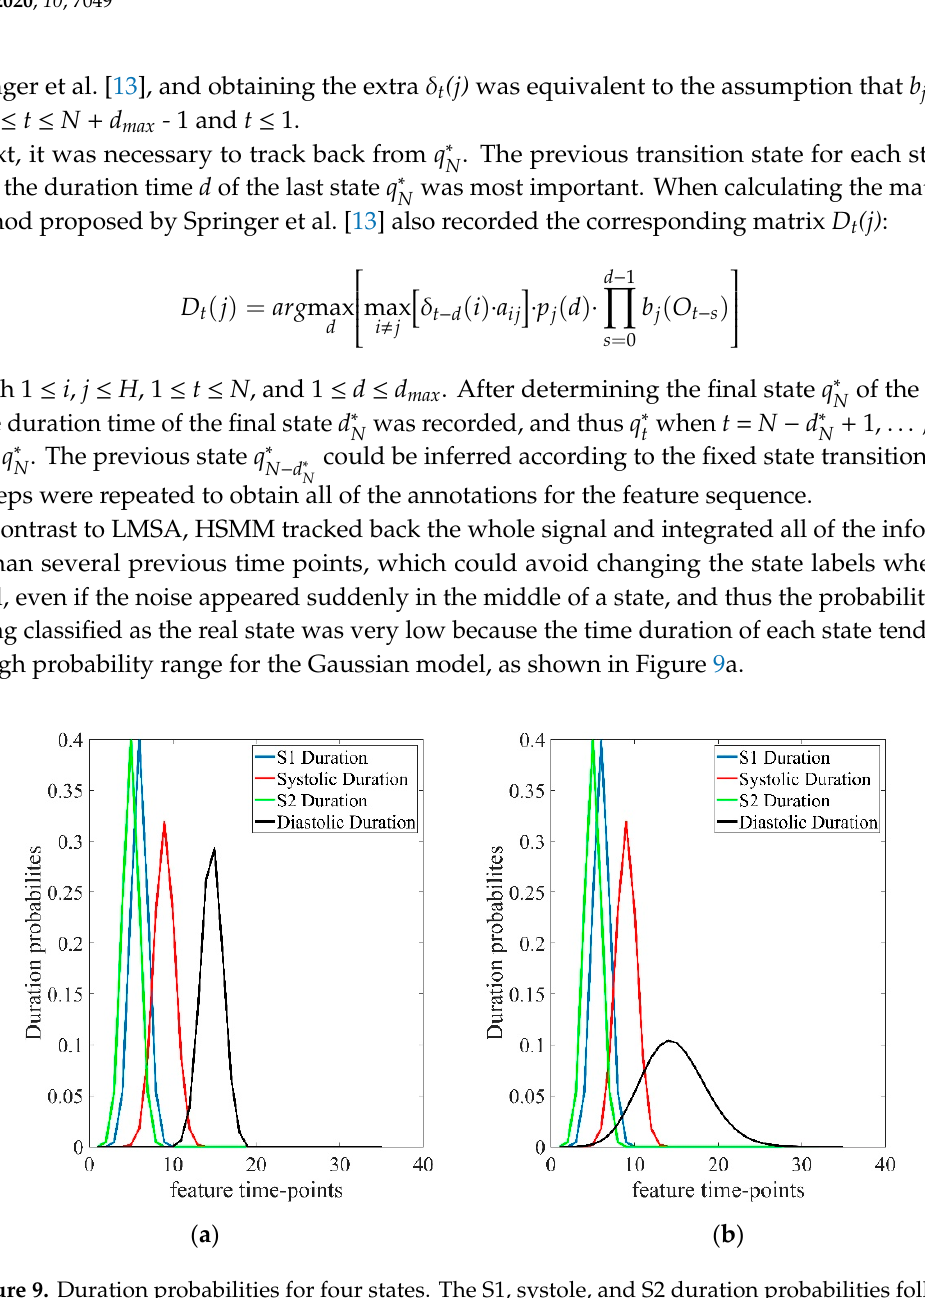
( b ) Figure 10. Comparison of different state annotation algorithms with arrhythmia heart sounds. ( a ) LH- training No. 555. ( b ) PN-training-a No. 7. TCN + gauss 1.0 used the previous Viterbi algorithm. TCN + Gauss 0.2 used the Viterbi algorithm changed the weights of the state duration probabilities. TCN + Poisson 1.0 used the Viterbi algorithm changed the diastolic distribution for Poisson distribution. 𝛿 (cid:3015)∗ (𝑞 (cid:3015)∗ ) = (cid:3537) 𝑝 (cid:3044) (cid:3284)∗∗ (𝑑 (cid:3036)∗ ) ∙ (cid:3537) 𝑏 (cid:3044) (cid:3285)∗ (cid:3435)𝑂 (cid:3037) (cid:3439) (cid:3015) (cid:3037)(cid:2880)(cid:2869)(cid:3038) (cid:3036)(cid:2880)(cid:2869)